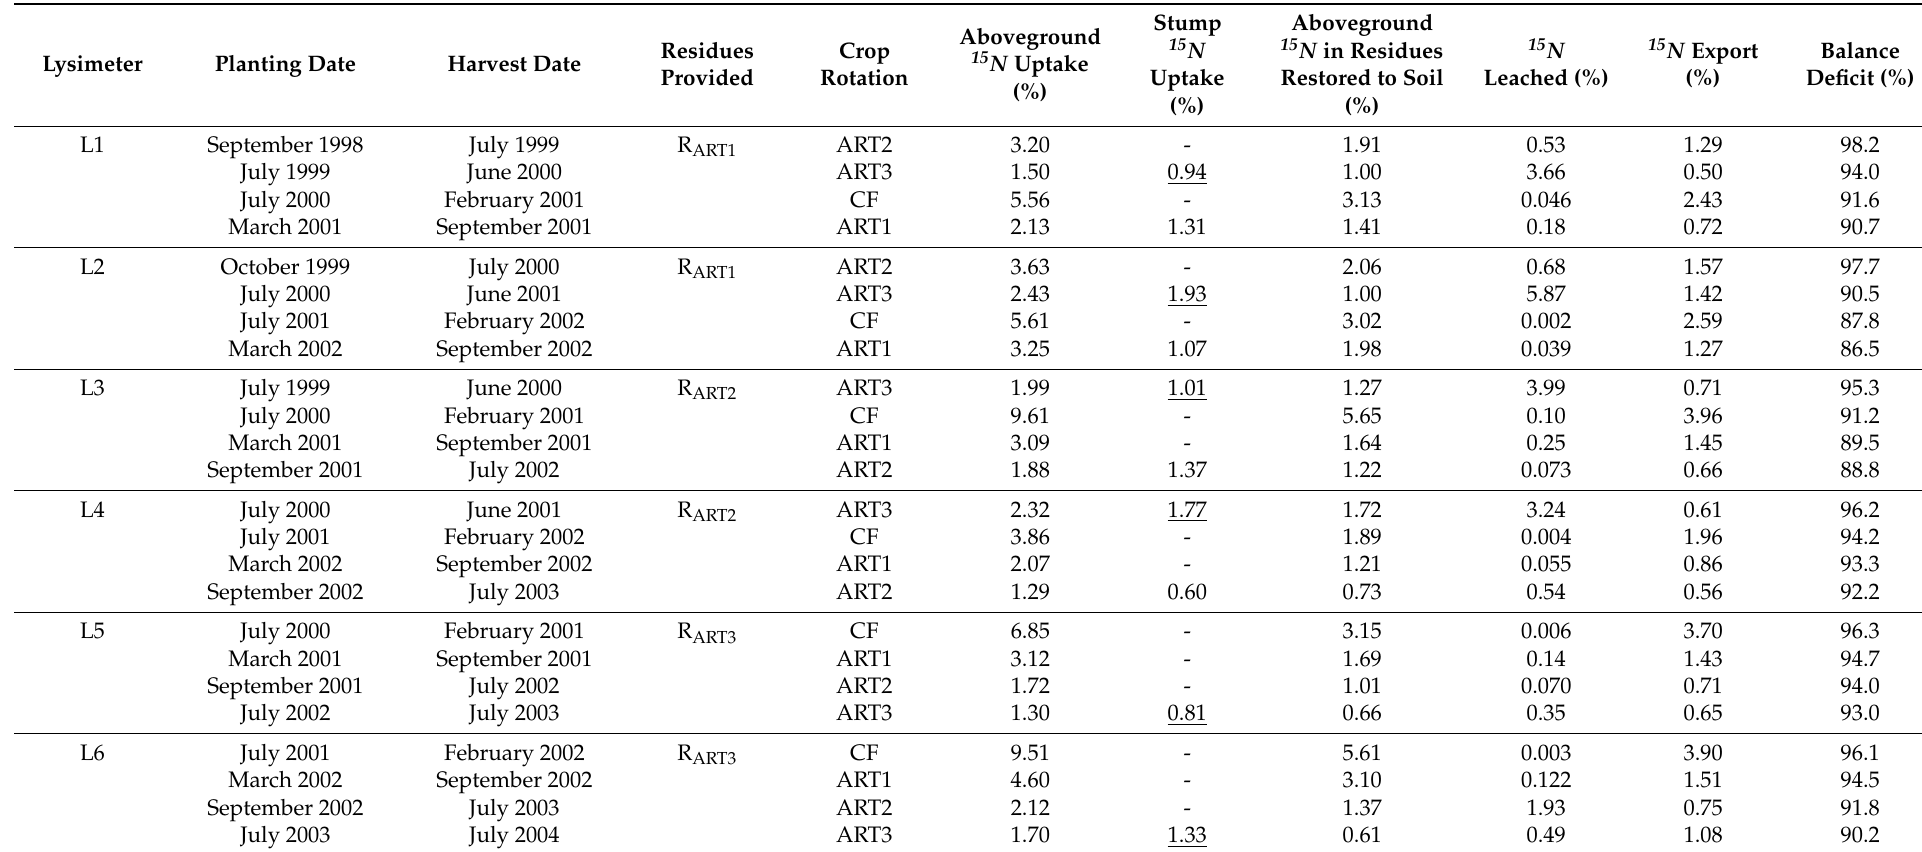
Table 4. Artichoke and cauliflower 15 N (%) uptake by the parts of each crop, 15 N amounts in crop residues, 15 N lost by nitrate leaching and 15 N exported by harvest measured in subsequent